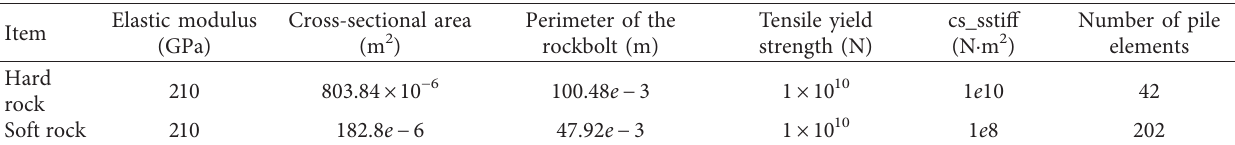
Figure 9: Schematic diagram of numerical simulation for the pull-out test. (a) Numerical model. (b) Pile elements, CID numbers, and node numbers in hard rock. Table 1: Simulation model input parameters for pile